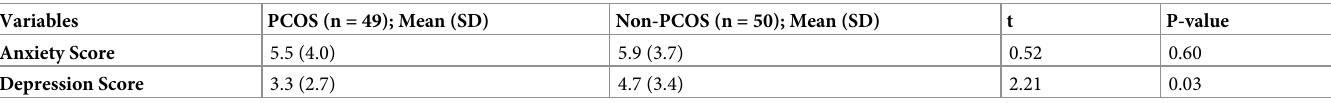
Table 2. Comparison of anxiety and depression scores between PCOS and non-PCOS groups.